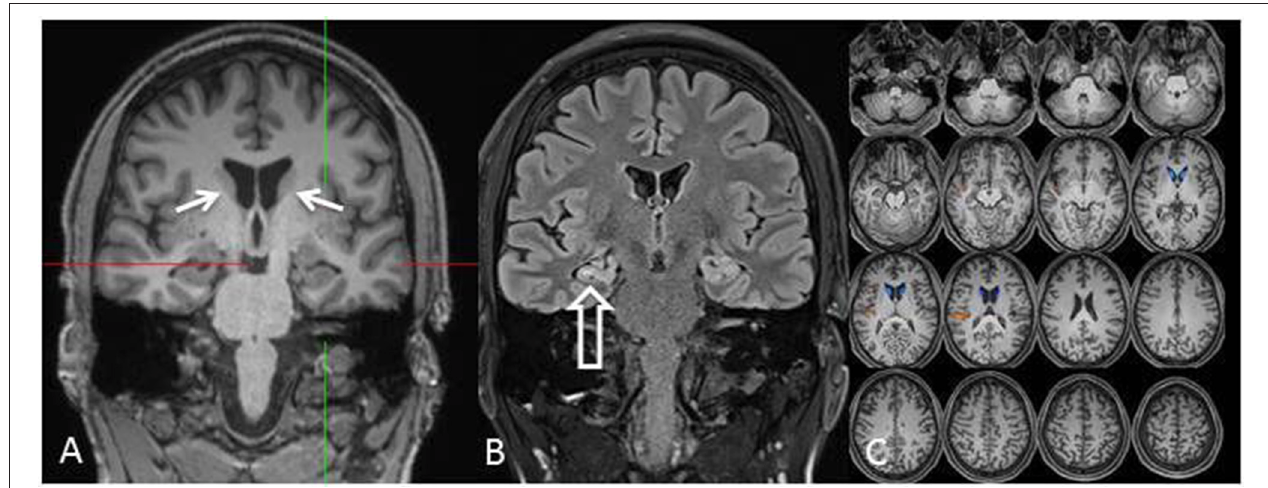
FIGURE 3 | MRI [coronal reformation of a MPRAGE sequence, (A) ; coronal FLAIR sequence, (B) ; z-score map of a combined voxel and region based (CVR) analysis, (C) ] shows discrete bilateral caudate head atrophy [ (A) : arrows] and a smaller and hyperintense right-sided hippocampus indicating right-sided hippocampal sclerosis [ (B) : hollow arrow]. The left hippocampus is somewhat hyperintense but not atrophic. Bilateral caudate head atrophy is confirmed with CVR analysis, in which blue colors show decreased gray and red colors increased cerebrospinal fluid volume, respectively (C) .